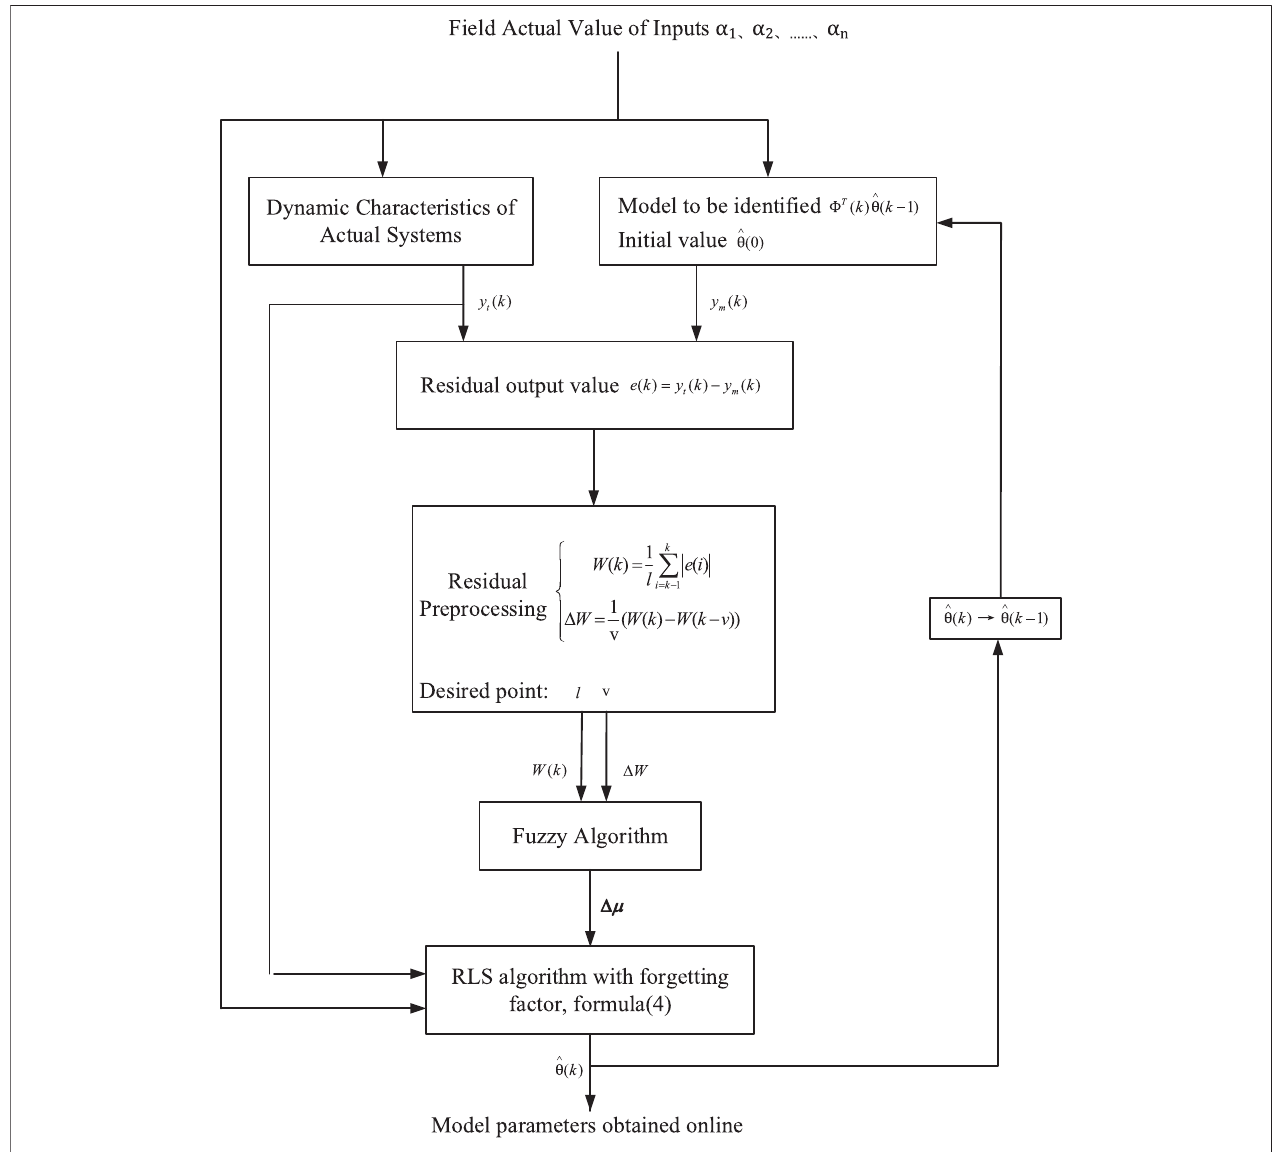
FIGURE 2 | Model identi fi cation of adaptive forgetting factor RLS